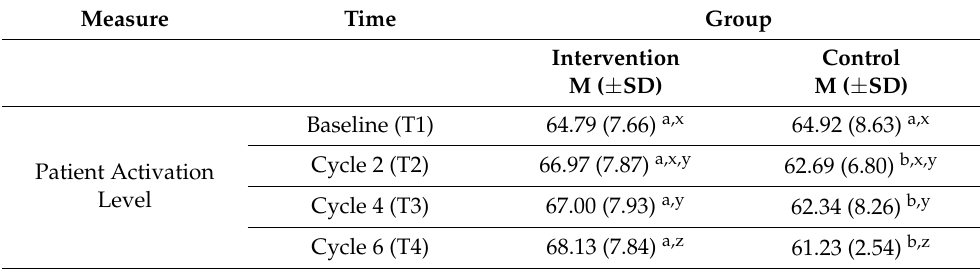
Table 2. Effect of SCEIP on PAM between and within intervention and control groups across time.